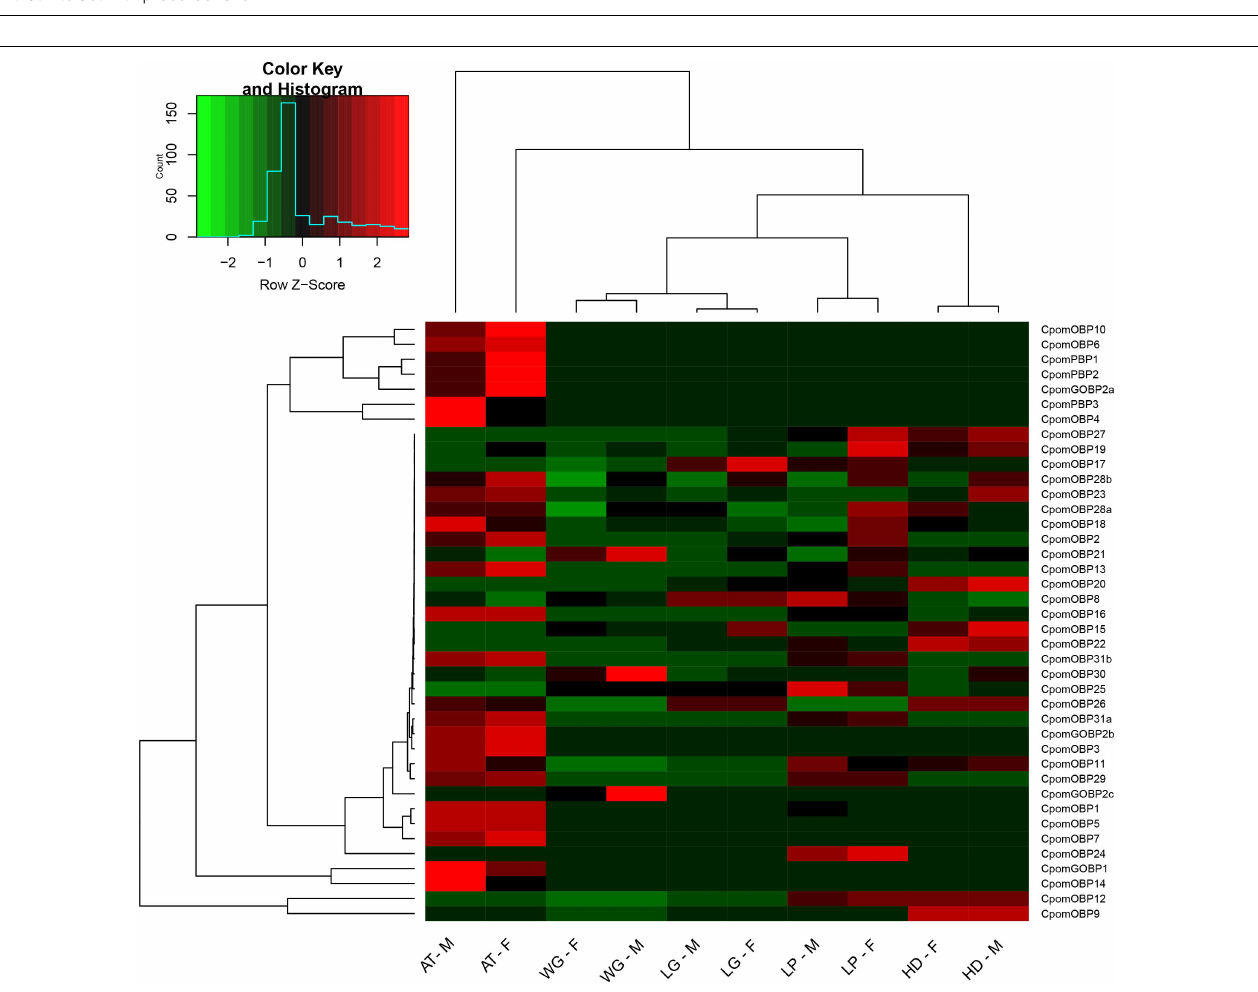
FIGURE 8 | Expression profiling of 40 CpomOBPs in different tissues. F, female; M, male; AT, antenna; HD, head (antennae removed); WG, wing; LG, leg; LP, labial palp.